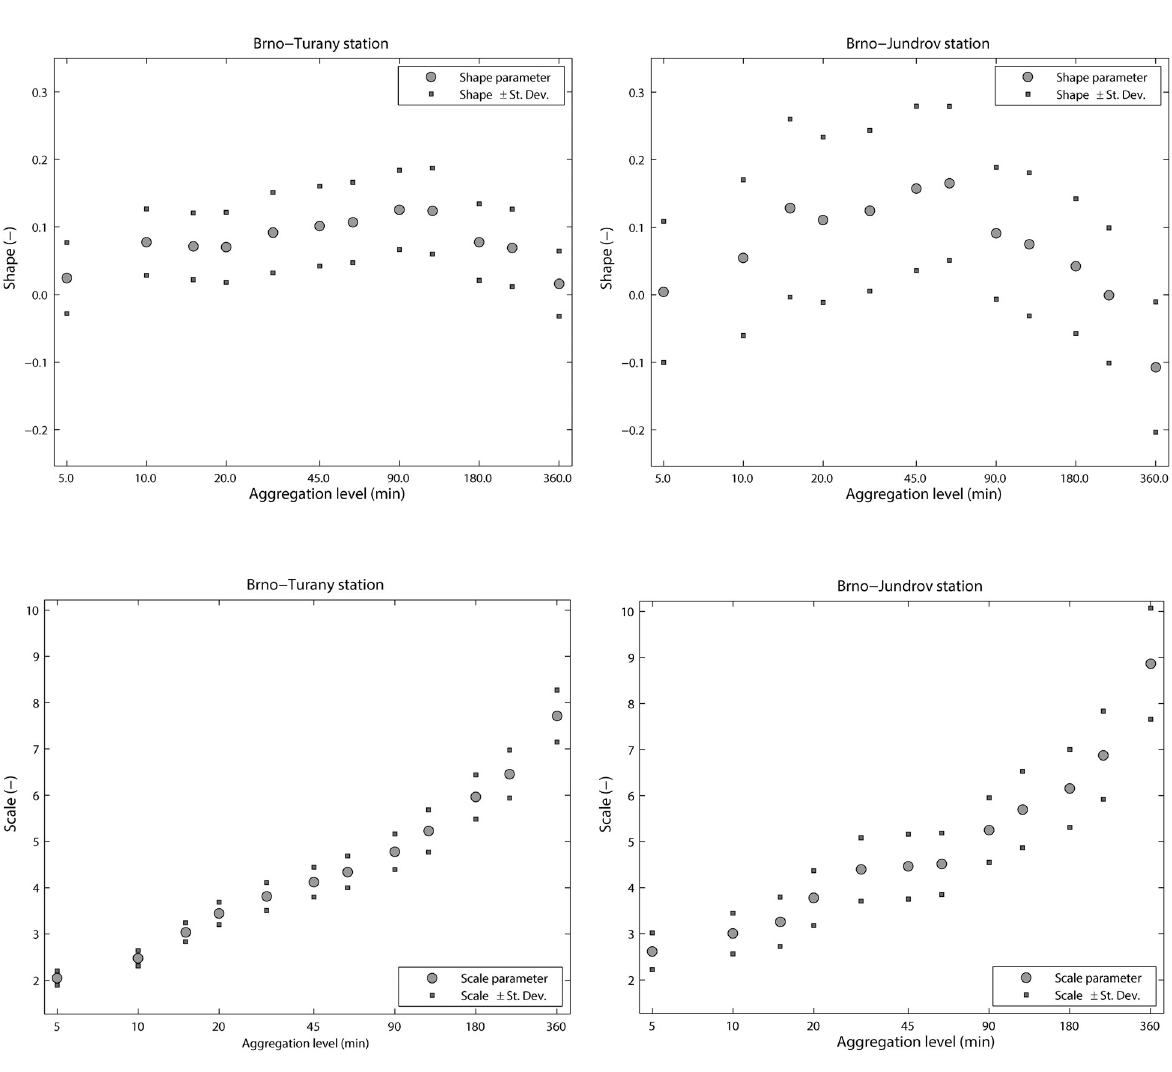
Fig. 4. Estimates of the scale and shape parameters and their standard deviation with a logarithmic scale on the x